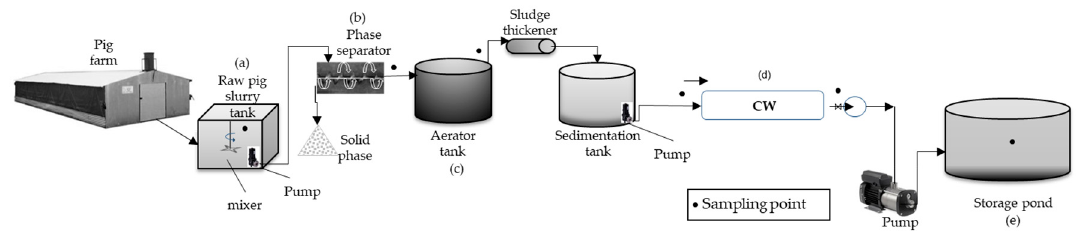
Figure 1. Scheme of the integrated purification system.